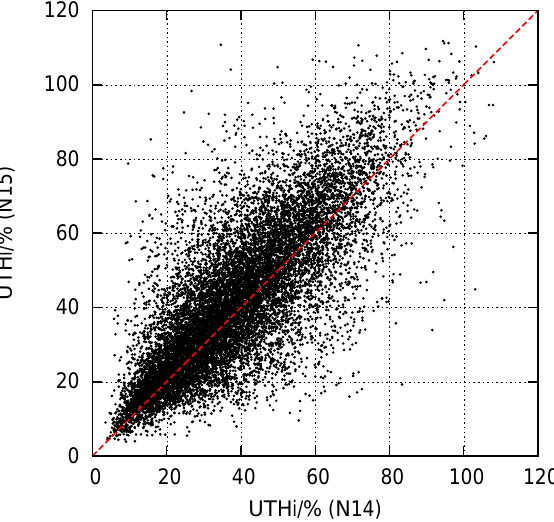
Figure 1. Scatter plot of data of upper-tropospheric humidity with respect to ice (UTHi, in percent), retrieved from channel 12 bright- ness temperatures from the HIRS 2 instrument on NOAA 14 and from the corresponding HIRS 3 instrument on NOAA 15. The data pairs represent daily average values taken in 2 . 5 ◦ × 2 . 5 ◦ grid boxes in the northern latitude belt of 30 to 70 ◦ N. The red dashed diag- onal ( y = x ) and the grid serve only to guide the eye. Ideally the data pairs would be arranged on the diagonal or at least symmetri- cally to it. However, it is evident that, in particular at high values of UTHi from NOAA 14 there are more data pairs above the diagonal, showing a tendency of the HIRS 3 instrument on NOAA 15 to give higher UTHi values than HIRS 2 on NOAA